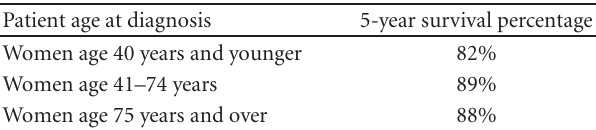
Table 2: Five-year survival in breast cancer patients according to